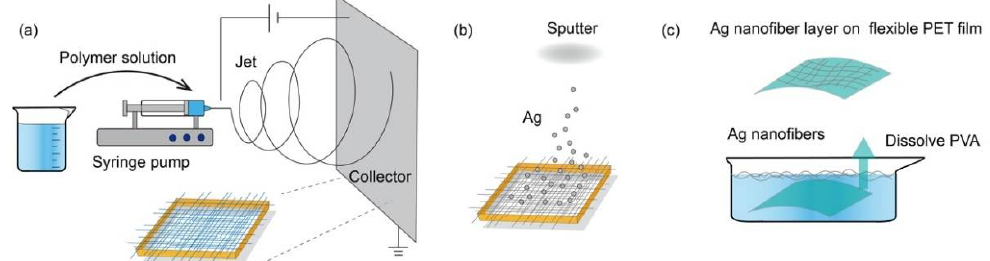
Figure 1. Schematic of the fabrication process of the Ag nanofibers (NFs) layer on the flexible polyethylene terephthalate (PET) film substrate. ( a ) Sketch diagram of the electrospinning of polyvinyl alcohol (PVA) NFs. ( b ) The simplified process of depositing Ag layer onto the surface of collected PVA NFs. ( c ) Diagram of dissolving the supporting PVA NFs core and transferring Ag NFs onto the flexible PET film surface.